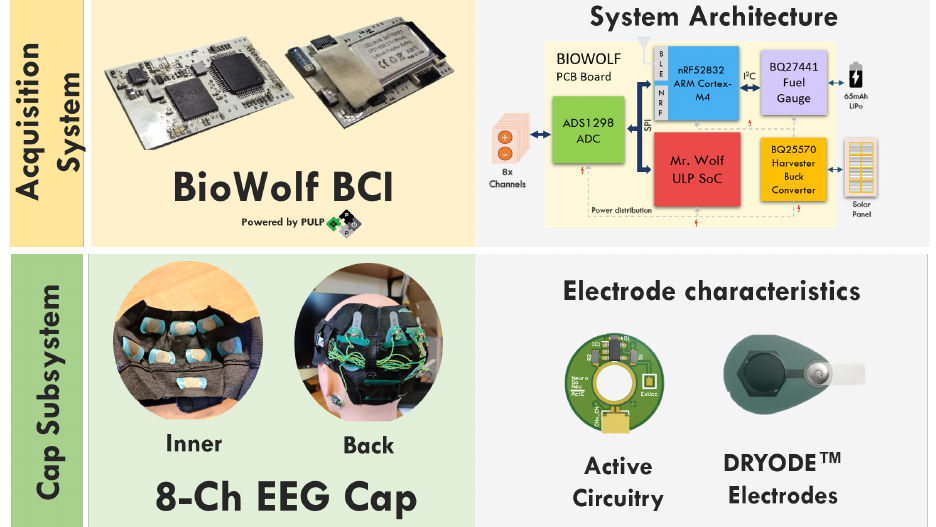
Figure 1. Portable EEG system embedding BioWolf and eight Dryode TM electrodes featuring active signal